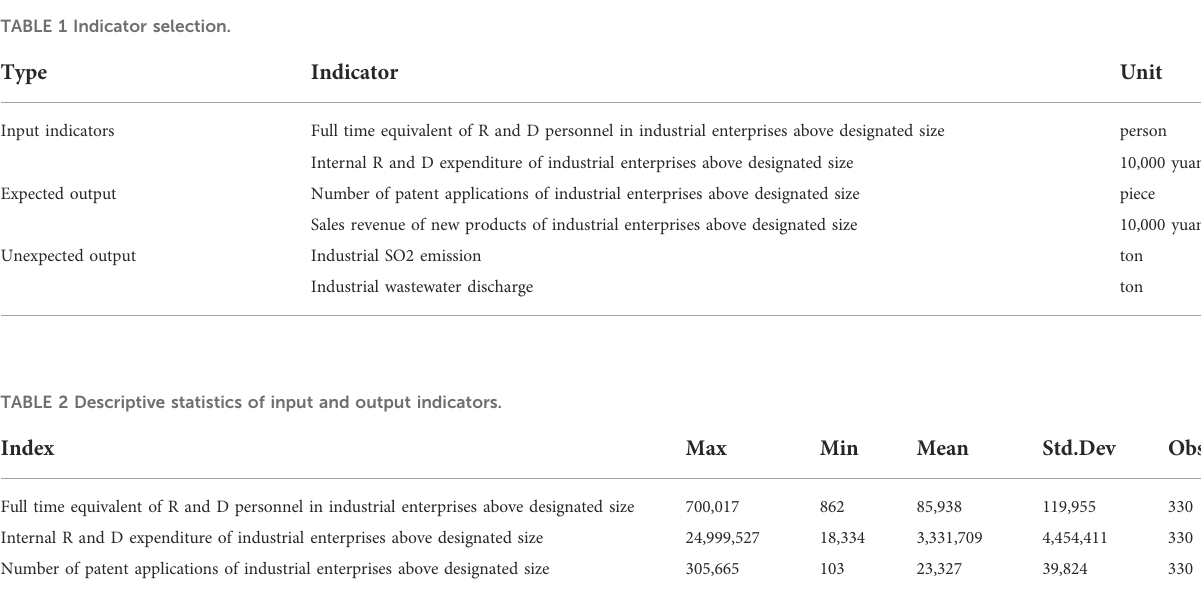
TABLE 1 Indicator selection.